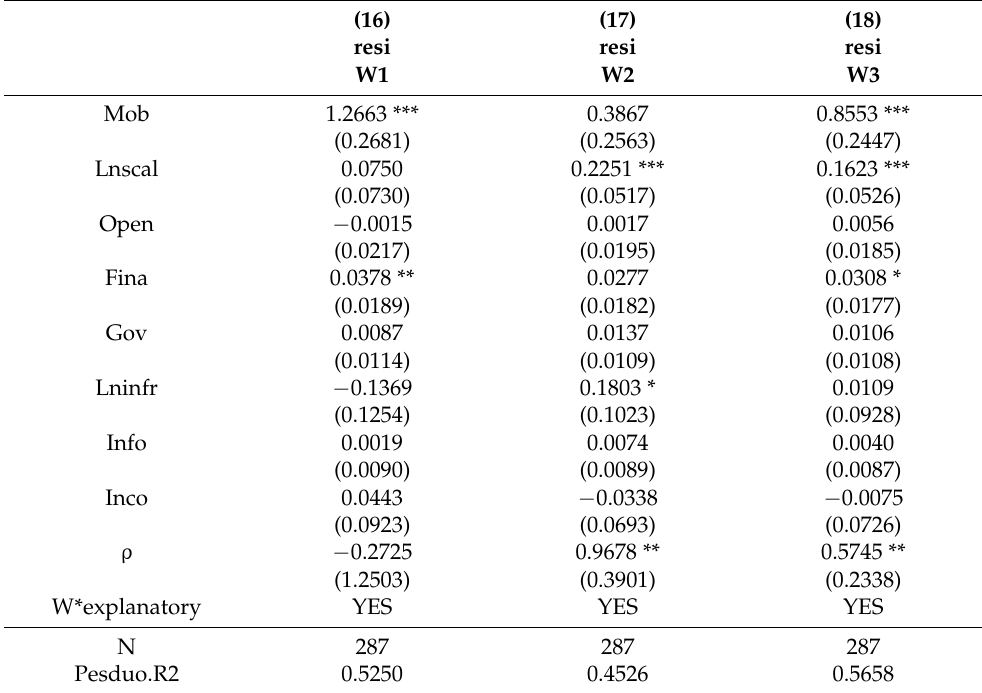
Table 7. Economic resilience and population mobility: join the